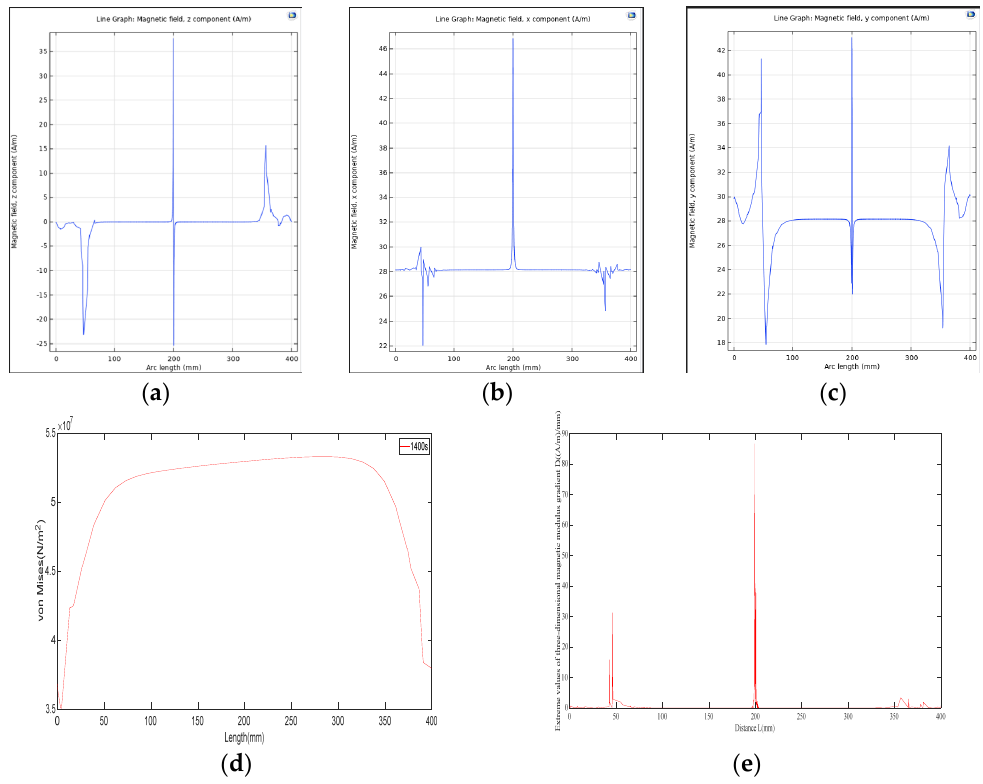
Figure 7. After 1400 s of heat dissipation. ( a ) Normal component Z; ( b ) Tangential component X; ( c ) Tangential component Y; ( d ) Equivalent stress distribution; ( e ) three-dimensional magnetic modu- lus gradient.